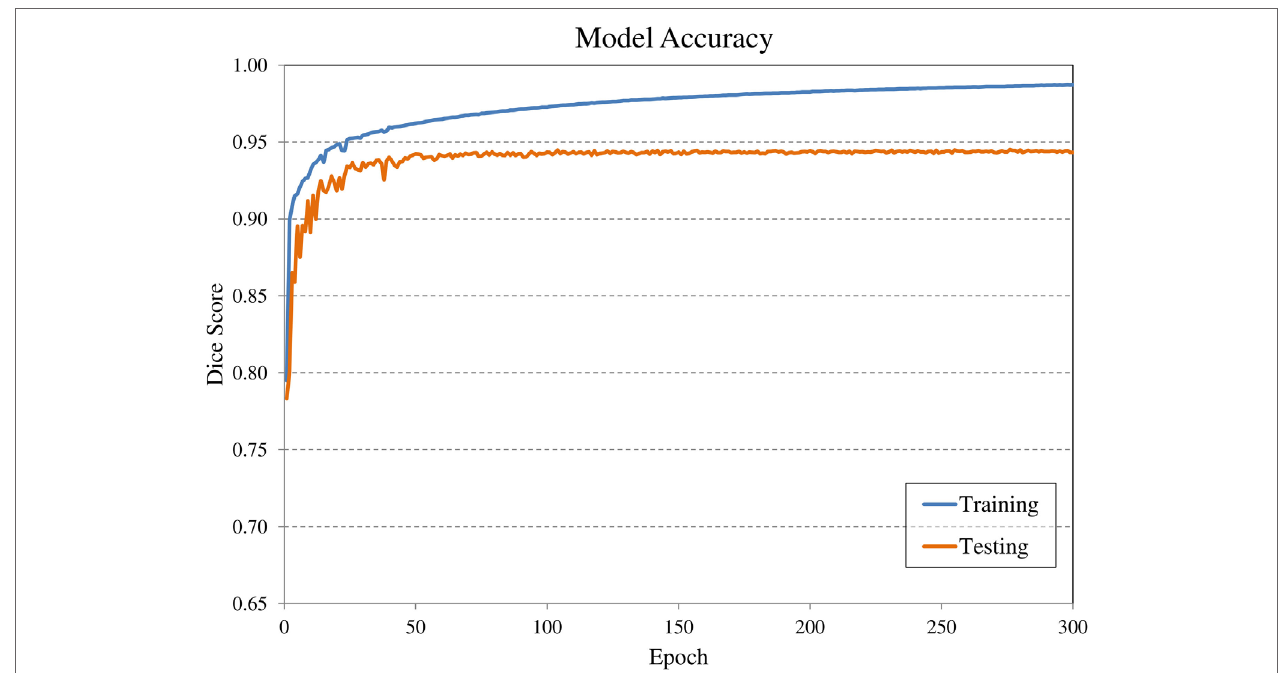
FigUre 3 | Evolution of model accuracy with over the 300 epochs for the training cohort (blue) and an augmented testing cohort (orange). Training required approximately 2.5 days for